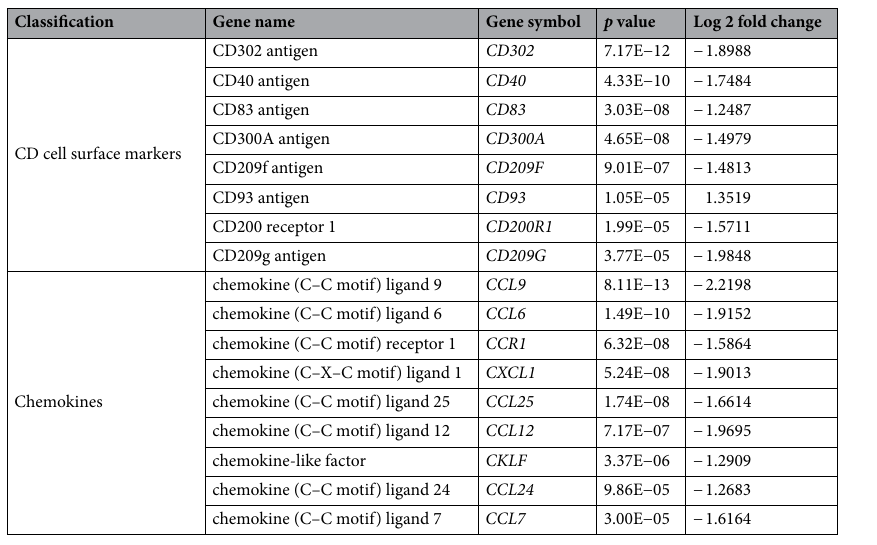
Table 2. List of innate immune system related genes differentially expressed in the pup brain, in response to maternal H. bakeri infection. Differential regulation as reported by Haque et al. 12 .